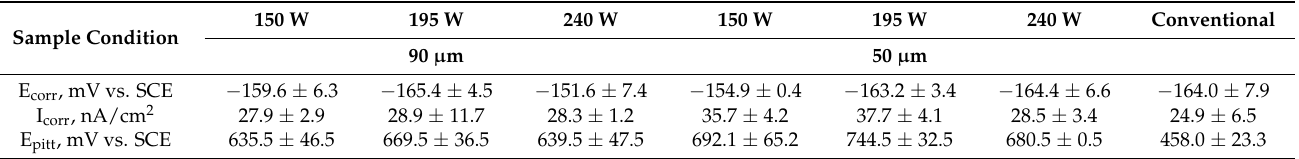
Table 2. Critical corrosion characteristics including corrosion potential E corr , corrosion current density I corr , and pitting potential E pitt , extracted from the potentiodynamic polarization scan. Sample